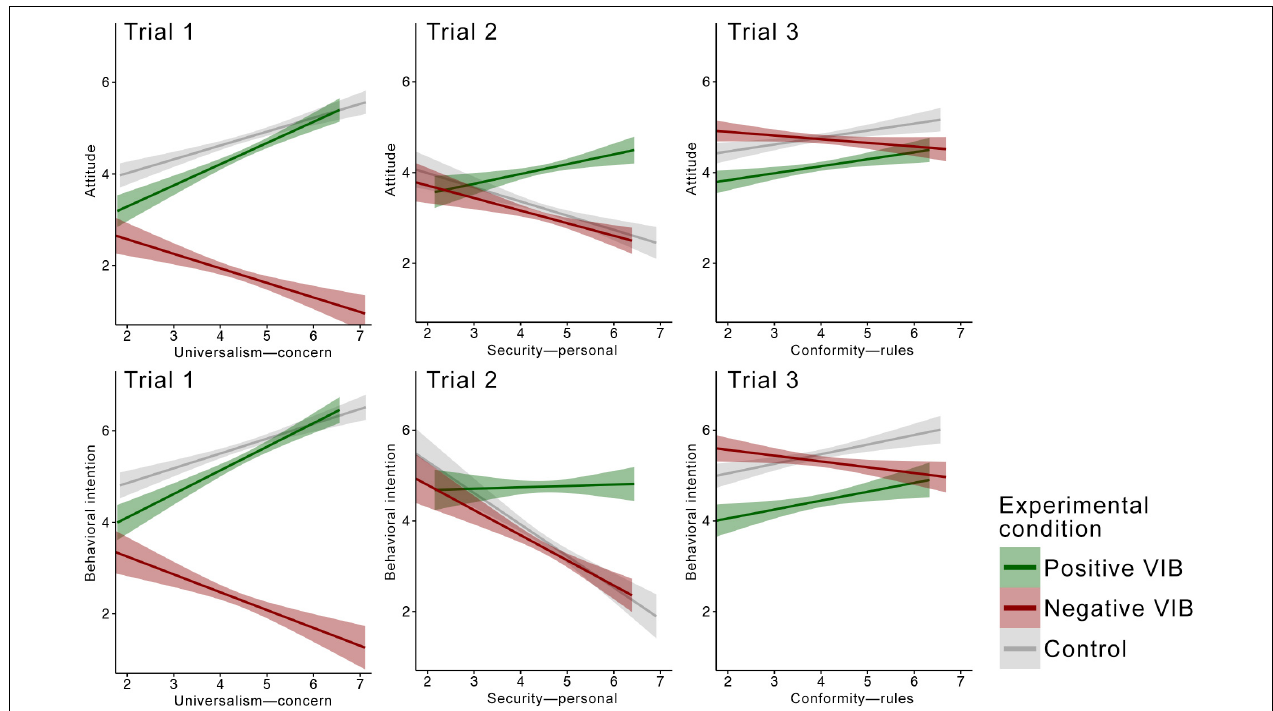
FIGURE 2 | Effects of value on attitude and behavioral intention in the three trials. OLS regression lines were calculated separately for each condition. Shaded bands represent 95% CI.